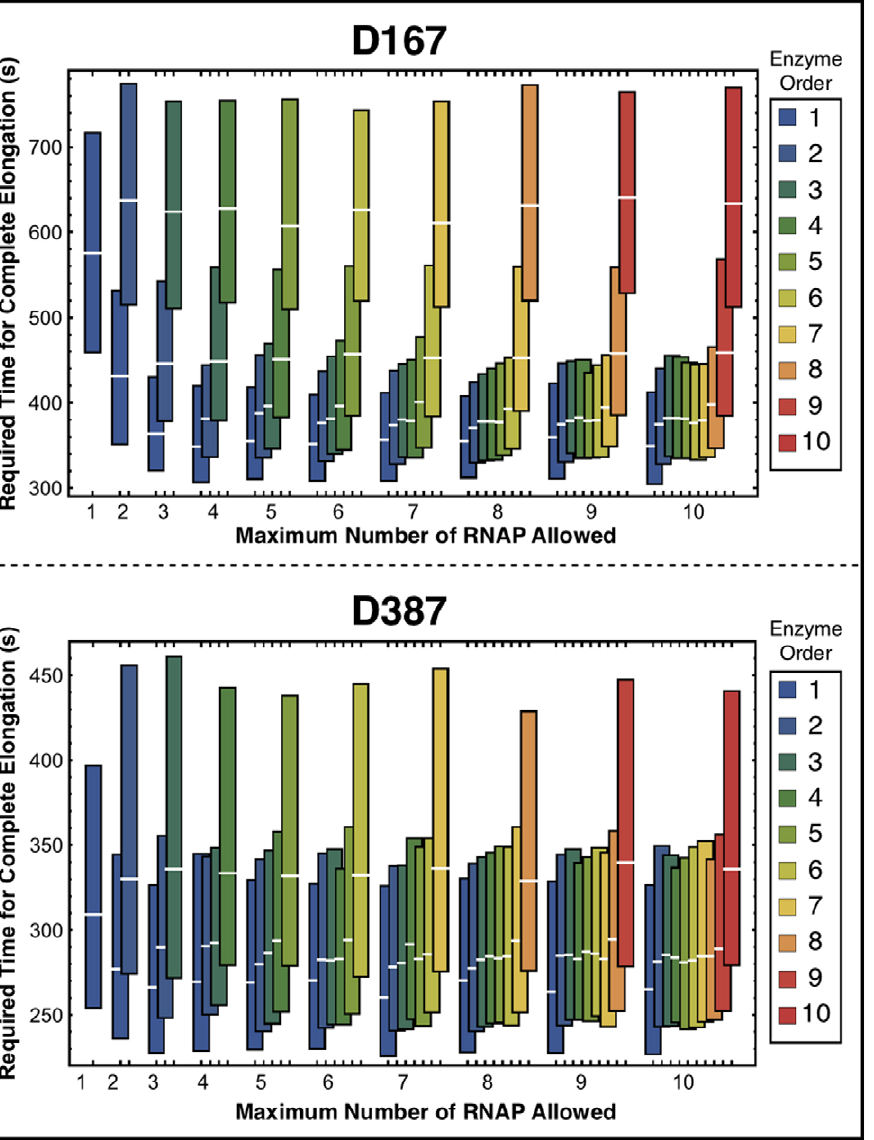
Figure 9. Required time for complete elongation for all RNAPs by the maximum number of RNAP allowed on the template: Distribution of the 4800 required times to complete transcription of the template by the maximum number of RNAP allowed. The upper and lower limits of each bar indicates respectively the first and third quartiles of these distributions, with a median highlighted in white. The colors represent the RNAP binding